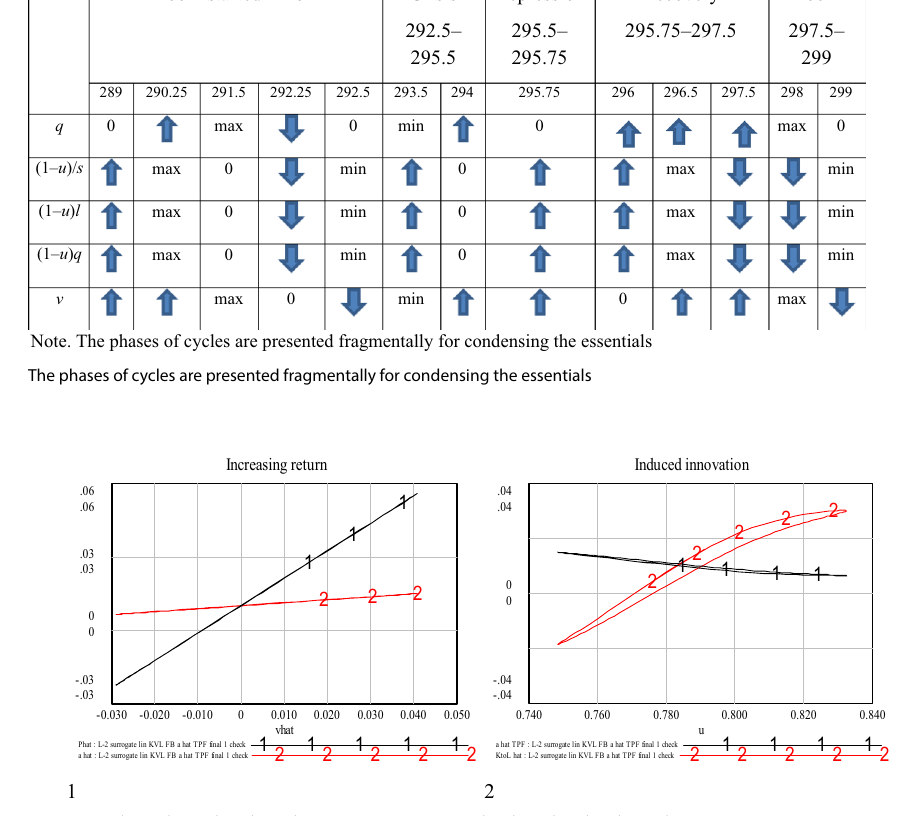
Fig. 12 The industrial cycle with increasing returns and induced technological progress in L-2, years 292.25–299: panel 1—growth rate of employment ratio vs growth rate of net output (1) and growth rate of output per worker (2); panel 2—relative wage u vs growth rate of output per worker (1) and growth rate of capital intensity (2)